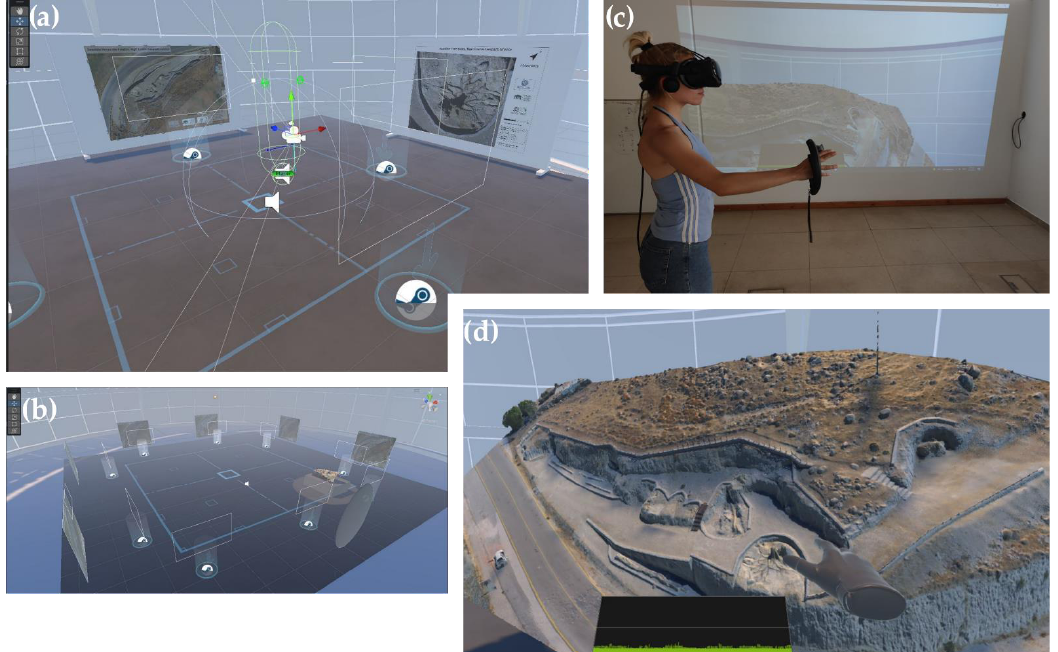
Figure 9. VR application: ( a ) multiscale room in Unity 3D Engine, ( b ) multitemporal room, panels, teleport area, and teleport points, ( c ) a user of the VR application, and ( d ) the corresponding image projected to the user in the VR headset via SteamVR.